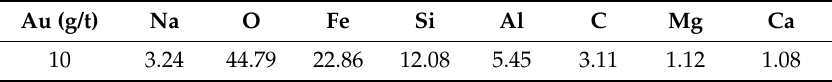
Table 1. Elemental composition of cyanidation tailings (mass fraction,